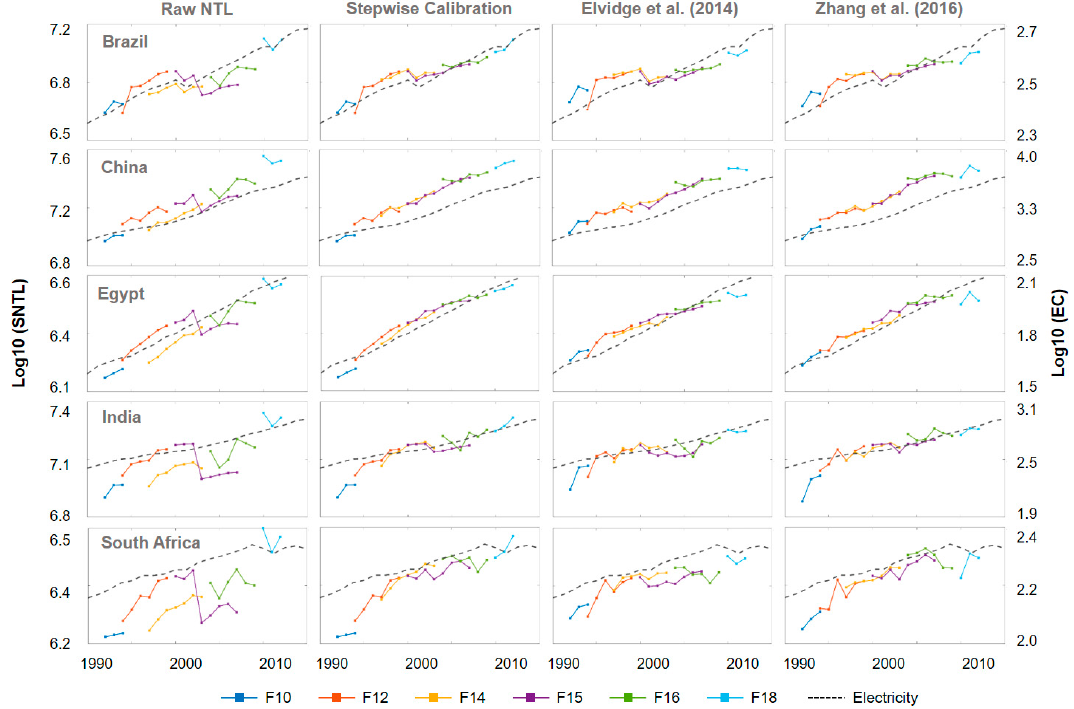
Figure 9. Comparison of the EC with the SNTL using three approaches in five representative countries.